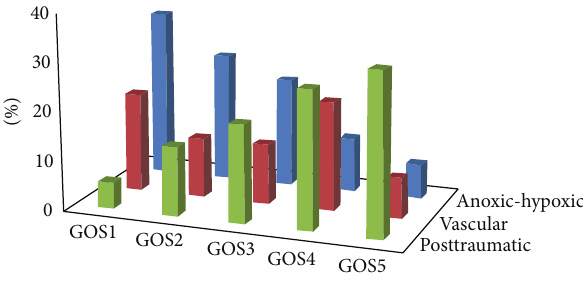
Figure 4: Overall outcome of patients in VS/UWS at admission in the years 1998–2013. The GOS classes are as follows: GOS1 = death; GOS2 = VS/UWS exceeding one year in duration; GOS3 = recovery, with severe disabilities; GOS4 = recovery, with mild disabilities; and GOS5 = full recovery or recovery with minimal disabilities not interfering with the everyday life